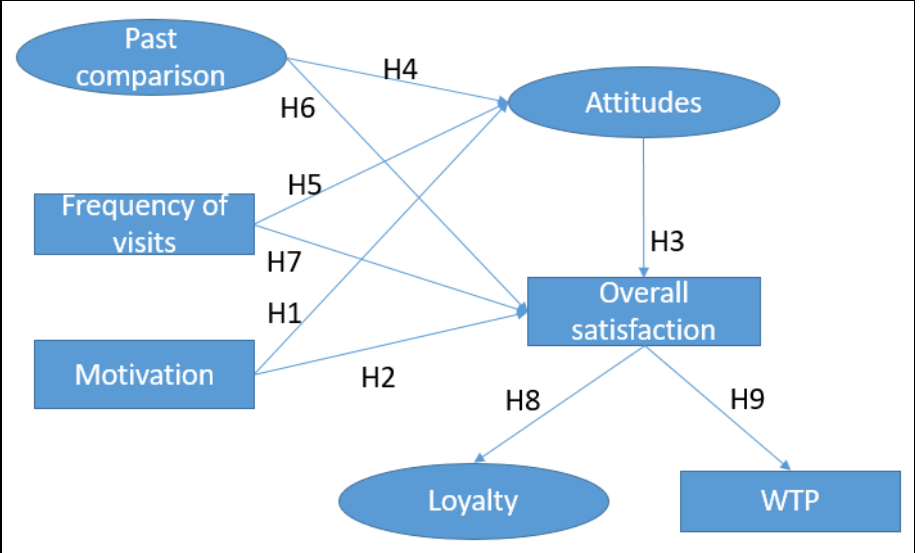
Figure 2. A conceptual SEM.